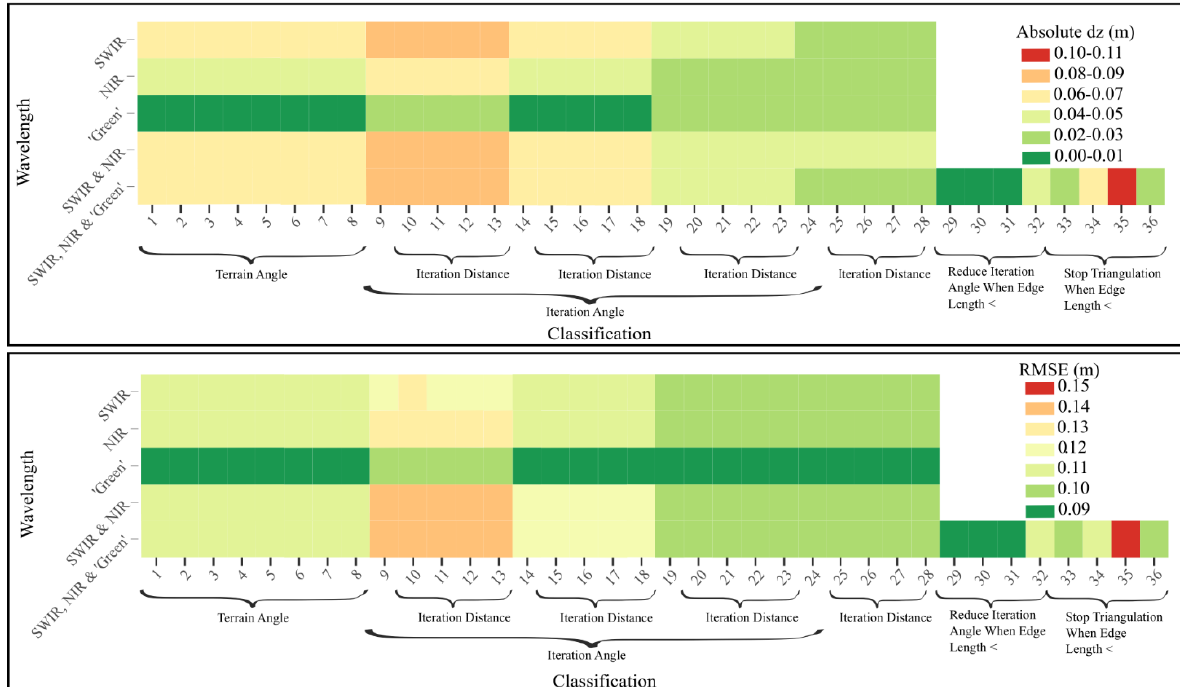
Figure 6. Ground classification results (| dz | and RMSE) in burned peatlands with low vegetation regeneration two years post-fire (as a proxy for immediately post-fire). Classifications were conducted in TerraScan.